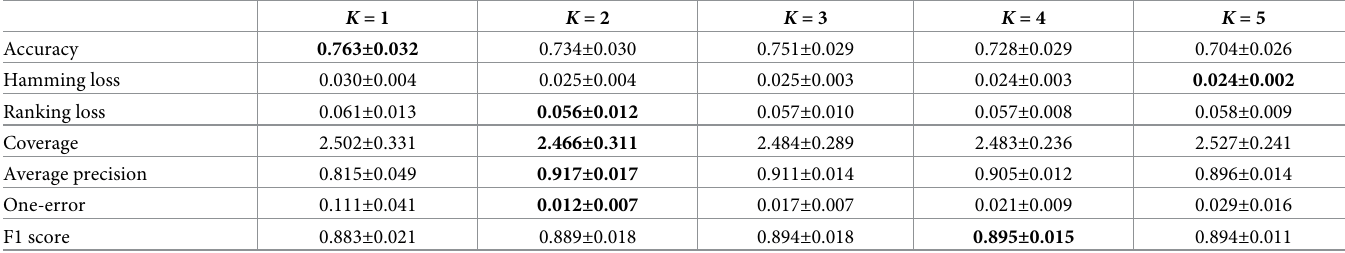
Table 3. Cross-validation results of the resistance variant for multiple fault location diagnoses.